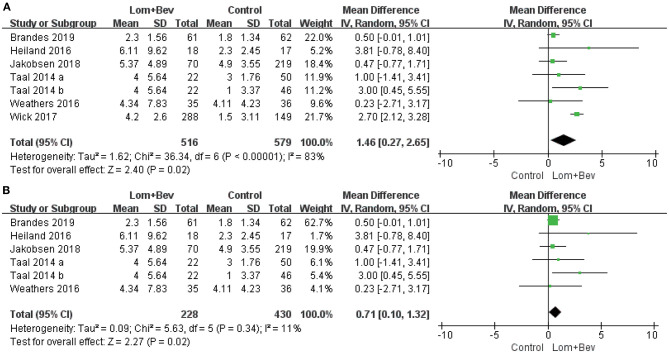
Forest plot of PFS in glioblastoma between lomustine plus bevacizumab and control groups. (A) All of the studies were included. (B) The study of Wick was removed. PFS, progression-free survival; Lom, lomustine; Bev, bevacizumab.